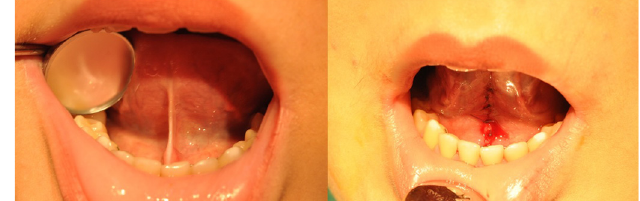
Fig. 2. Presence of a short lingual frenulum limiting the elevation of the tongue (right photograph) and a postoperative photograph of the lingual frenectomy (left